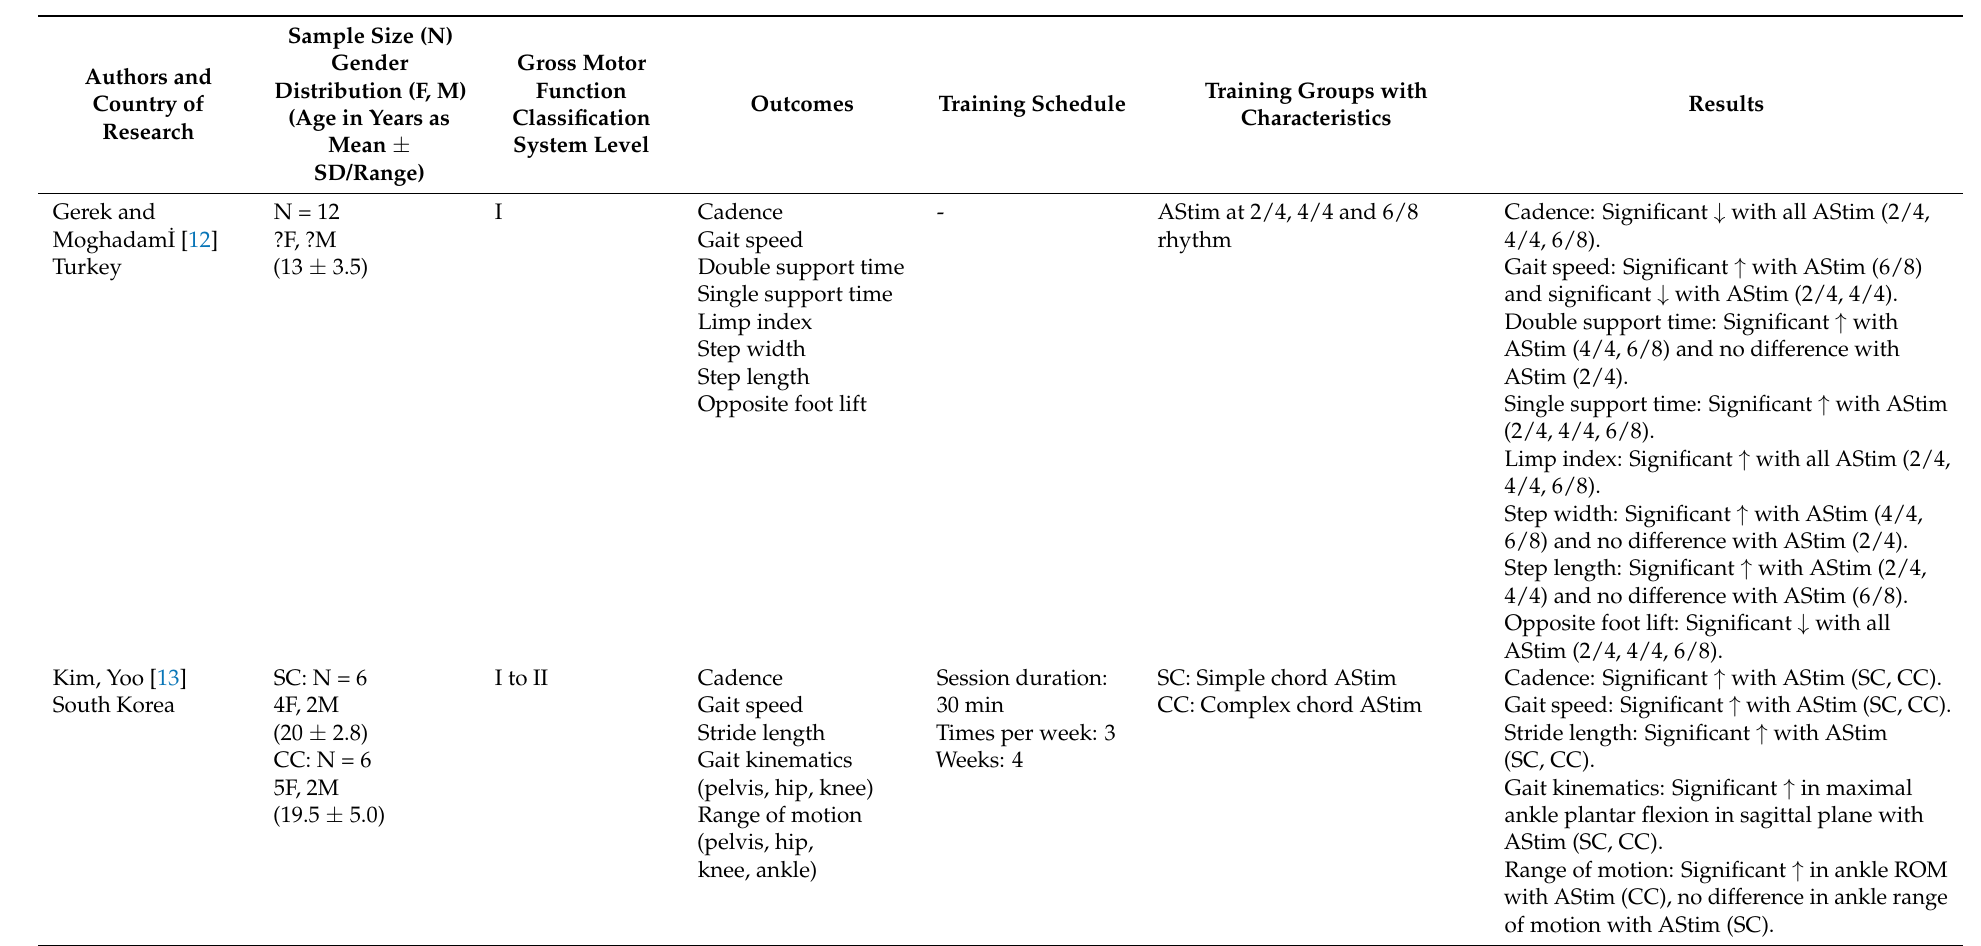
Table 1. Details of the included